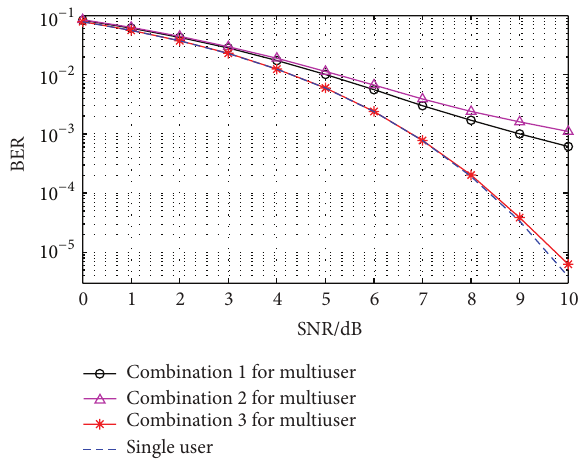
Figure 8: Performance of each combination mode in an asyn- chronous